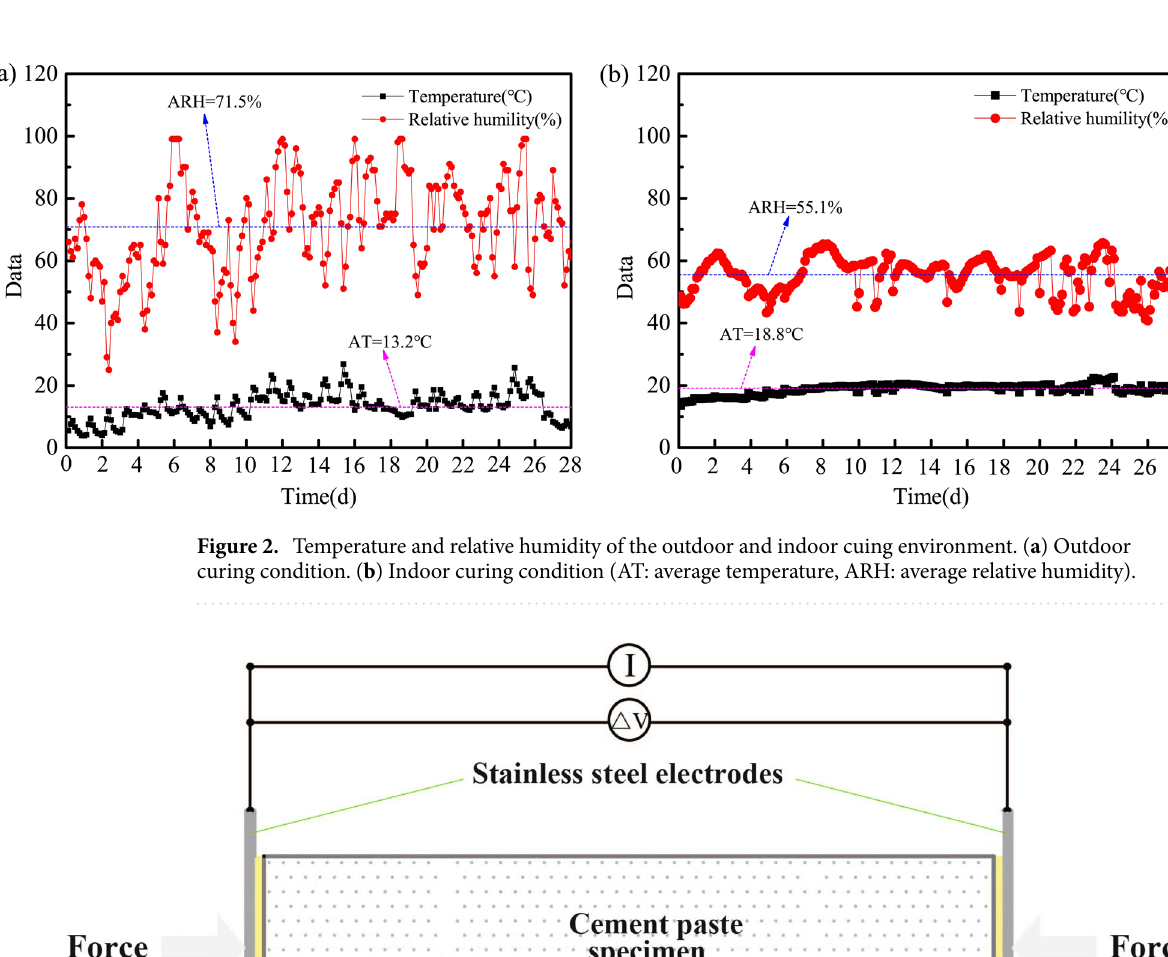
Table 2. Different curing conditions used in this study.